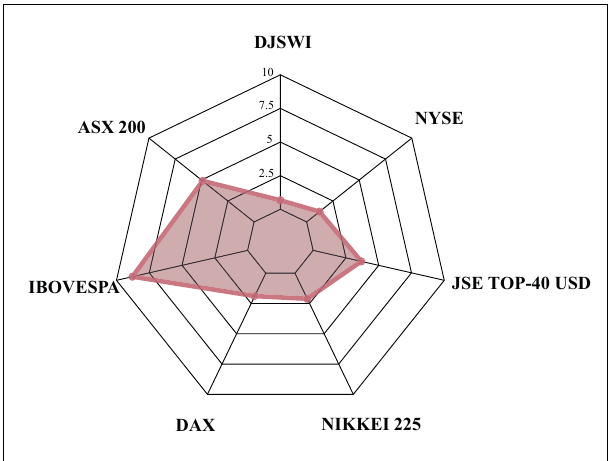
Figure 7. Radar chart of the highest-frequency wavelets levels registered in each financial market (COVID-19 vs.